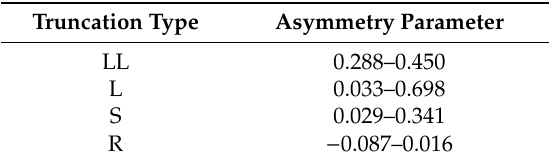
Table 2. Range of asymmetry parameter values for each truncation